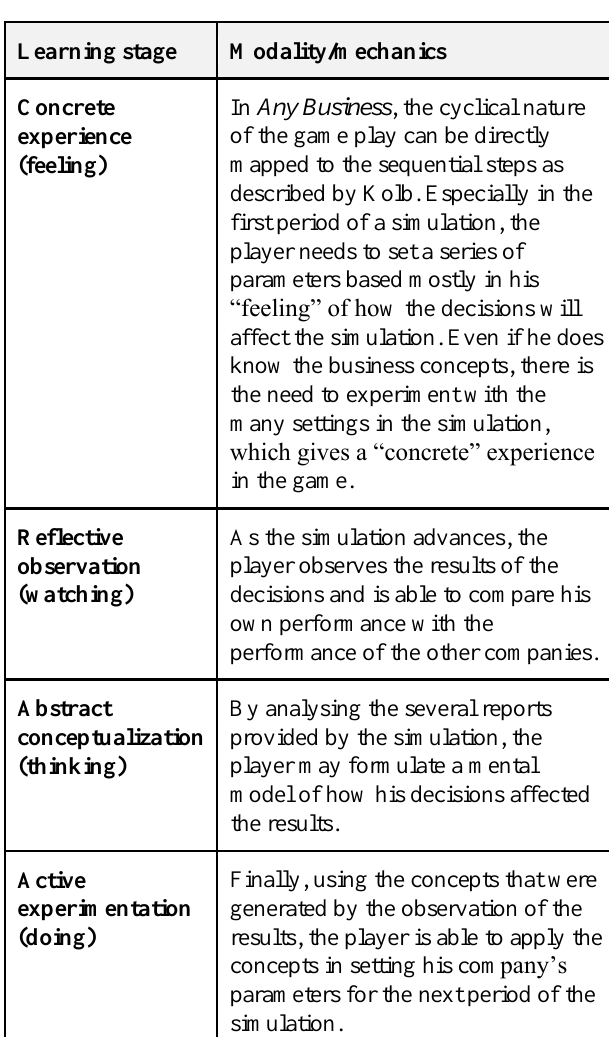
Table 5 : Kolb’s learning cycle Any